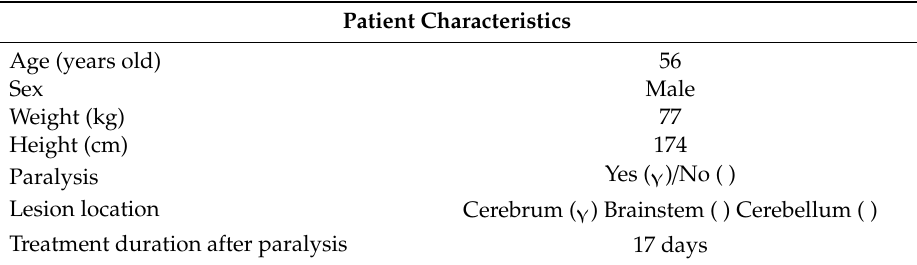
Table 1. Demographics of the patient.